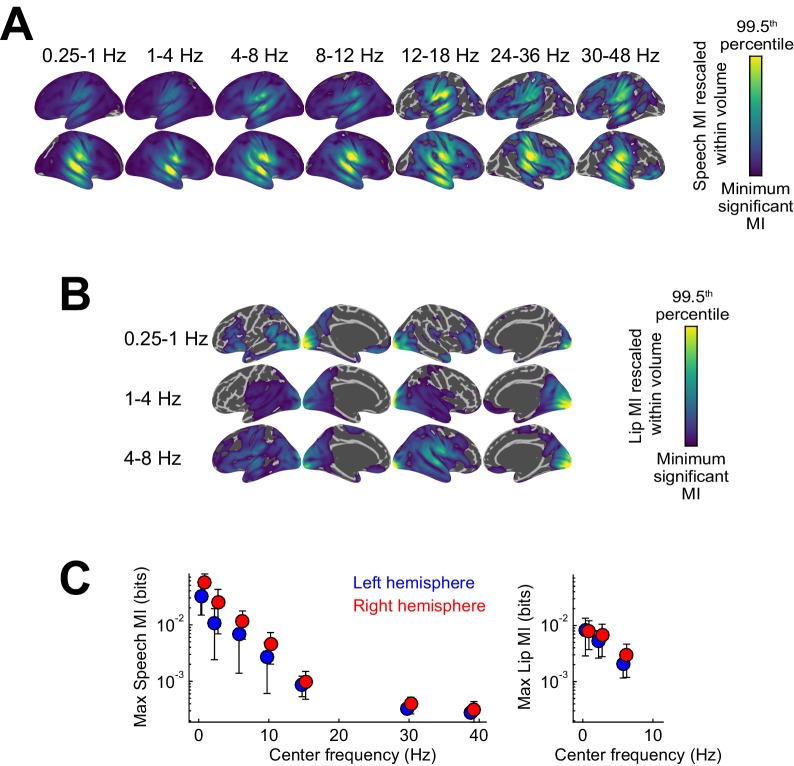
Entrainment of rhythmic MEG activity to the speech envelope and lip movements.(A) Projection of significant speech MI maps, which quantify the entrainment of MEG source activity to the speech envelope, onto the Freesurfer template (FWE = 0.05; proximity = 10 mm; surface-projected significant MI maps rescaled within volume from minimum significant MI to the 99.5th percentile of the surface projection). (B) Projection of significant lip MI maps. (C) Peak speech / lip MI values in the two hemispheres as a function of frequency (mean ± SEM). Deposited data: SE_meg; SE_speech; SE_miS; LE_meg; LE_lip; LE_miL.